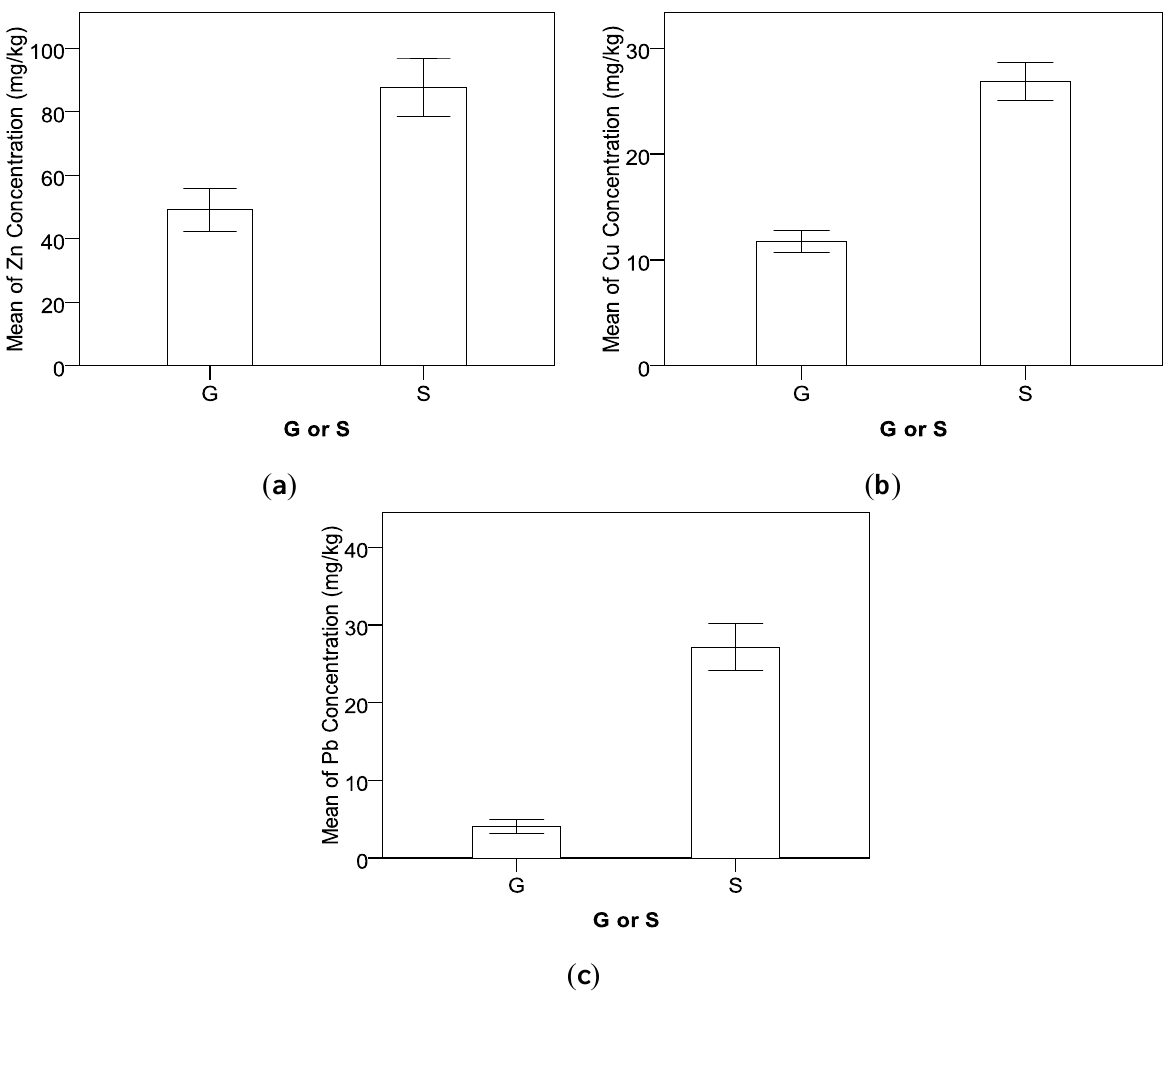
Figure 4. Difference of heavy-metal concentrations between grass and soil